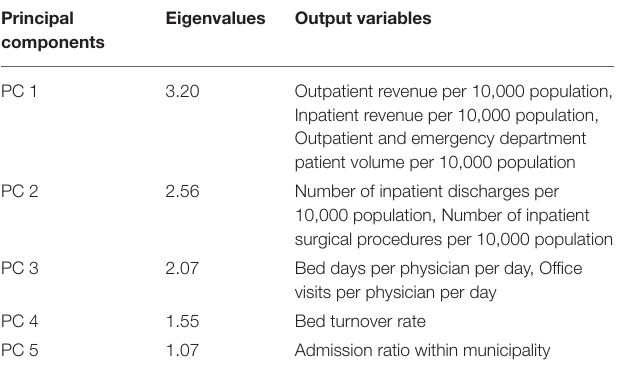
TABLE 3 | Principal components from principal component